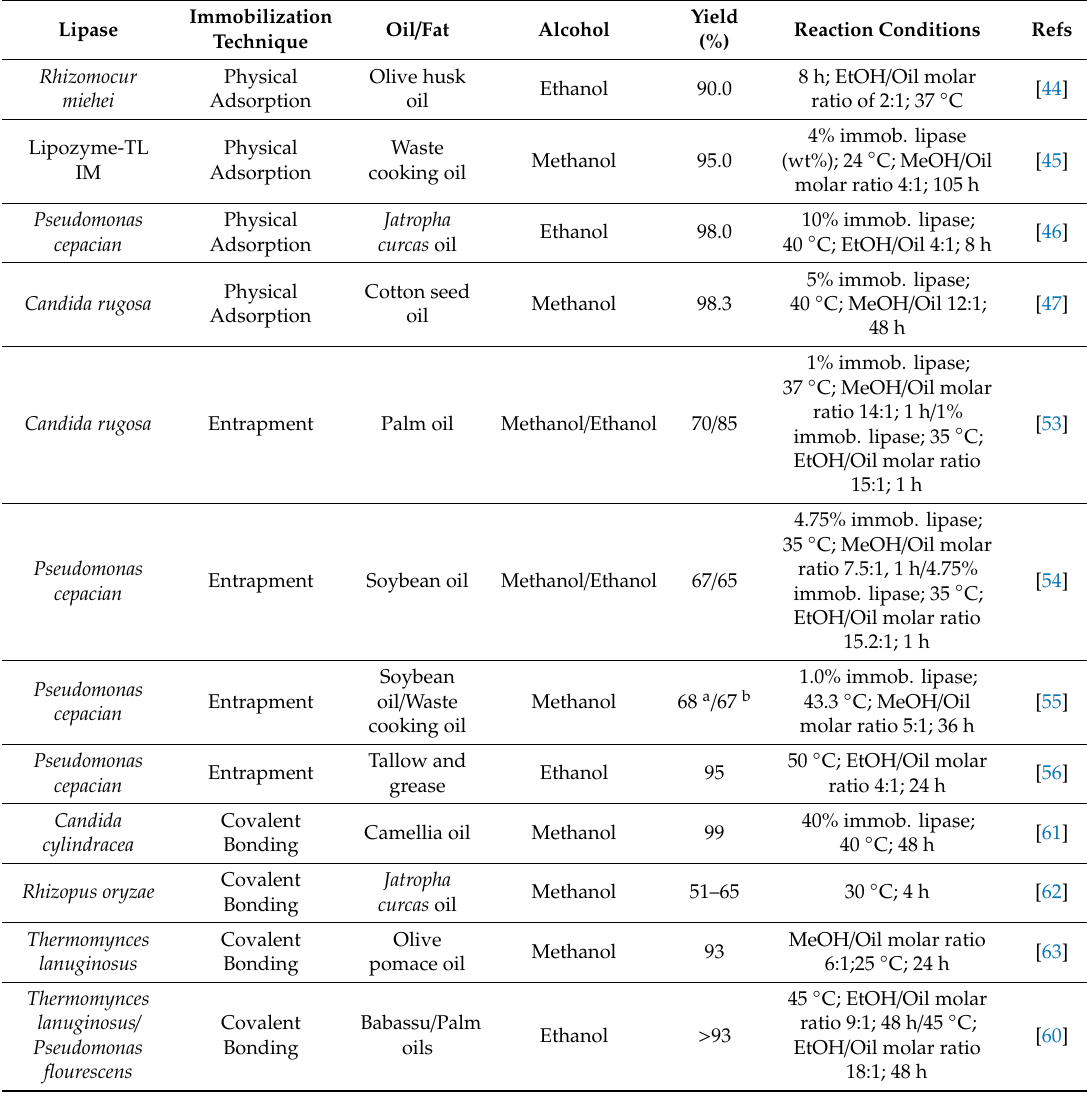
Table 1. Summary of examples of lipase immobilization techniques used in biodiesel